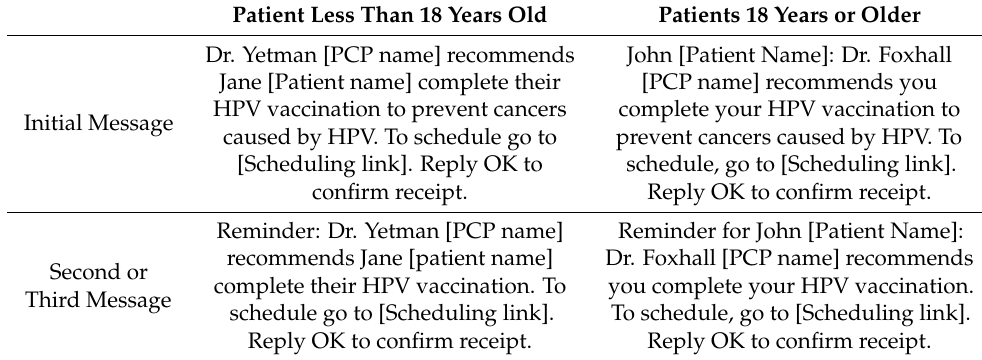
Table 1. Message framework for electronic patient reminders for